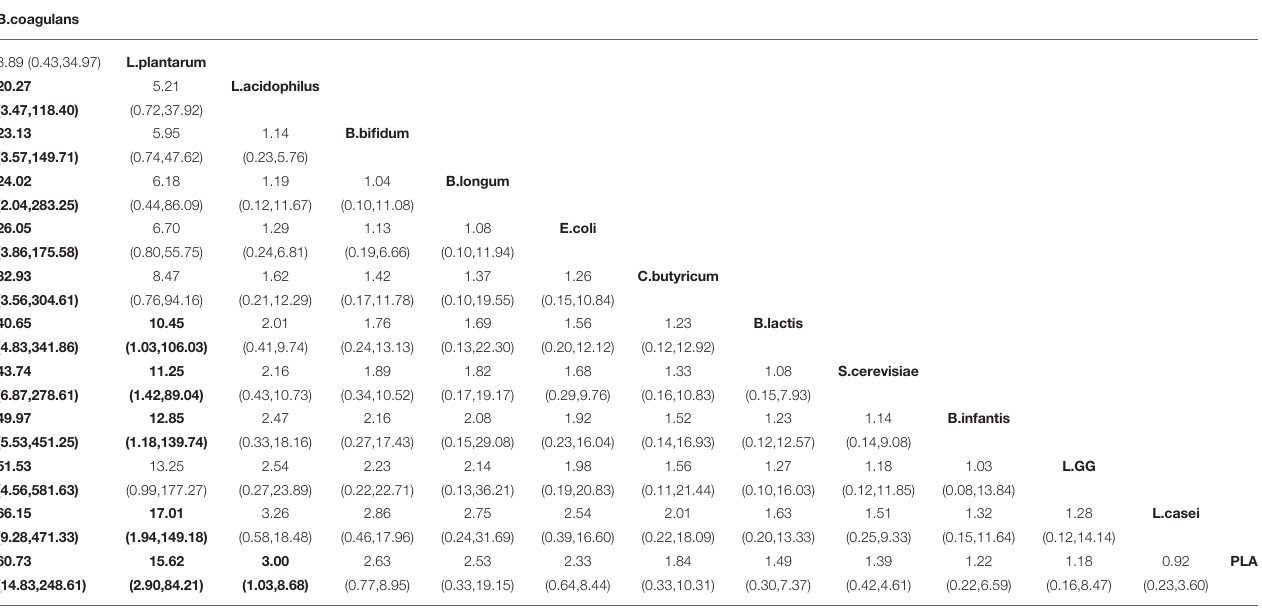
TABLE 2 | Odds ratio (OR) with 95% con fi dence interval on symptom relief rate.